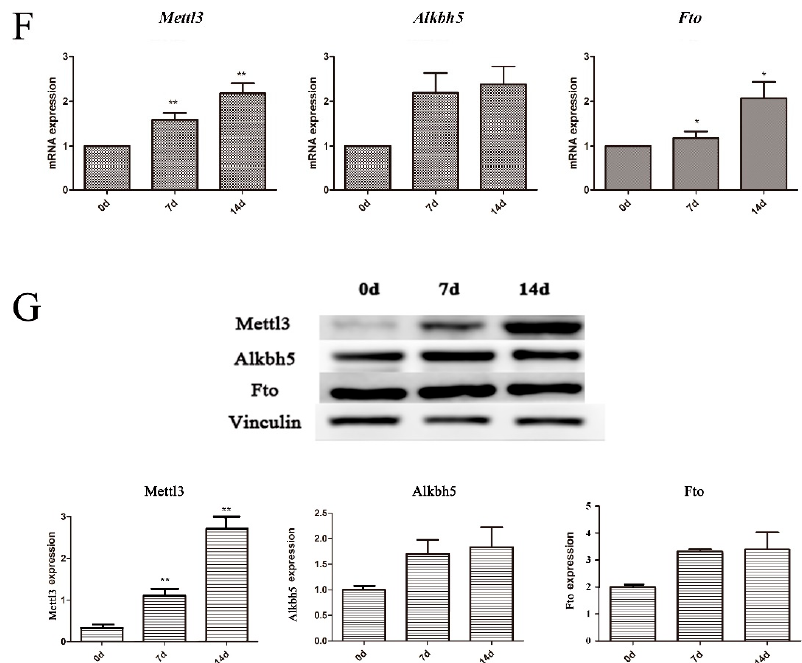
Figure 2. Osteogenic differentiation of BMSCs and expression of m 6 A methyltransferase and demethylases. ( A , B ) The formation of mineralized nodules was analyzed in BMSCs undergoing osteogenic differentiation on Days 7, 14, and 21. The “white” scale bars represent 100 µ m (original magnification × 100). ( C ) ALP activity assays. ALP activity was significantly higher in the cells cultured in osteogenic differentiation medium for seven days. ( D ) The expression of Runx2 , Alp and Ocn was assessed using qRT-PCR on Days 7 and 14 of culture in osteogenic induction medium. Gapdh was used as an internal control. ( E ) The expression of Runx2 and Osterix was examined using Western blotting. Vinculin was used as an internal control. The band intensities were analyzed using ImageJ software. ( F , G ) RNA methylation modification-related enzymes were detected using qRT-PCR and Western blotting in cells cultured in osteogenic induction medium for 7 and 14 days. Gapdh was used as an internal control for qRT-PCR. Vinculin was used as an internal control in Western blotting. All of the results represent the mean ± standard deviation of three independent experiments ( n = 3). Significant difference compared with the control (* p < 0.05; ** p < 0.01; *** p <